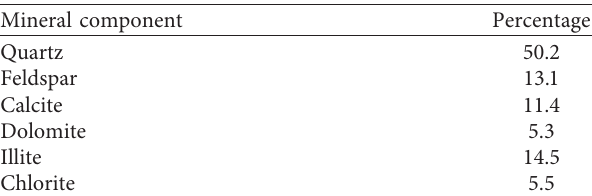
Table 2: Mineral component of the tested material.